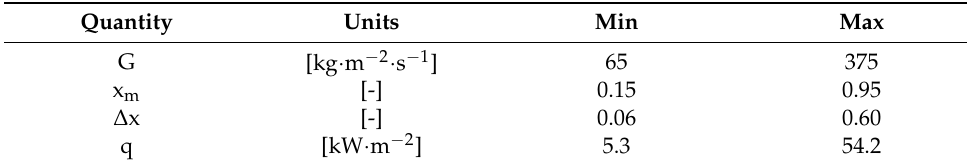
Table 2. Experimental operating conditions.